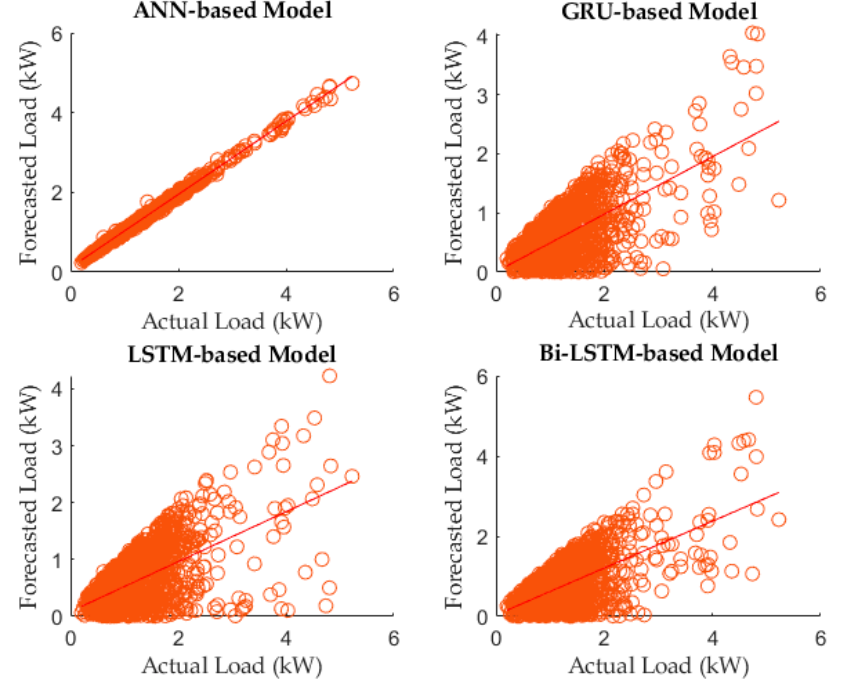
Figure 8. Scatter Plot ANN, LSTM, GRU, and Bi-LSTM models.